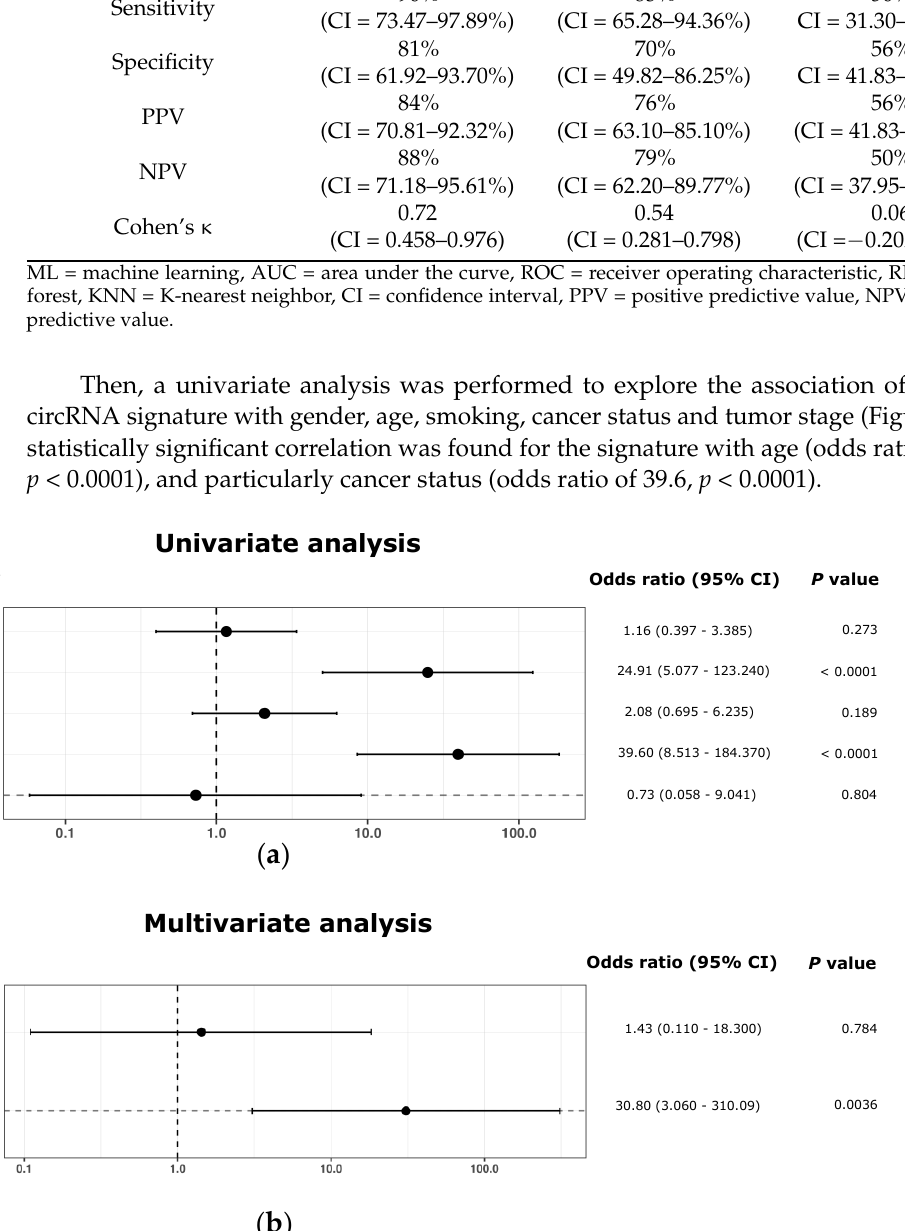
Table 4. Association between age and cancer status. Statistic